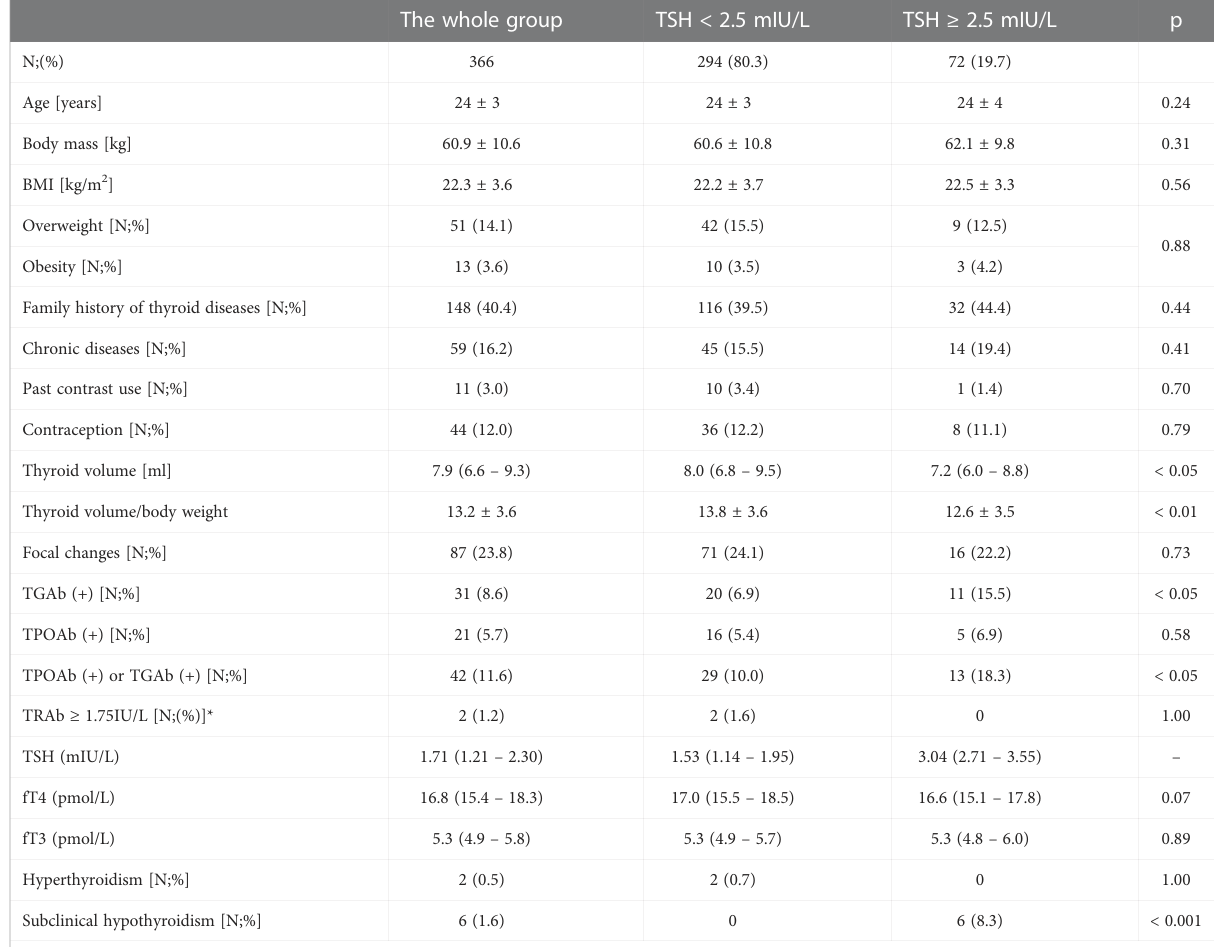
TABLE 1 The characteristics of the whole group and subgroups divided according to TSH